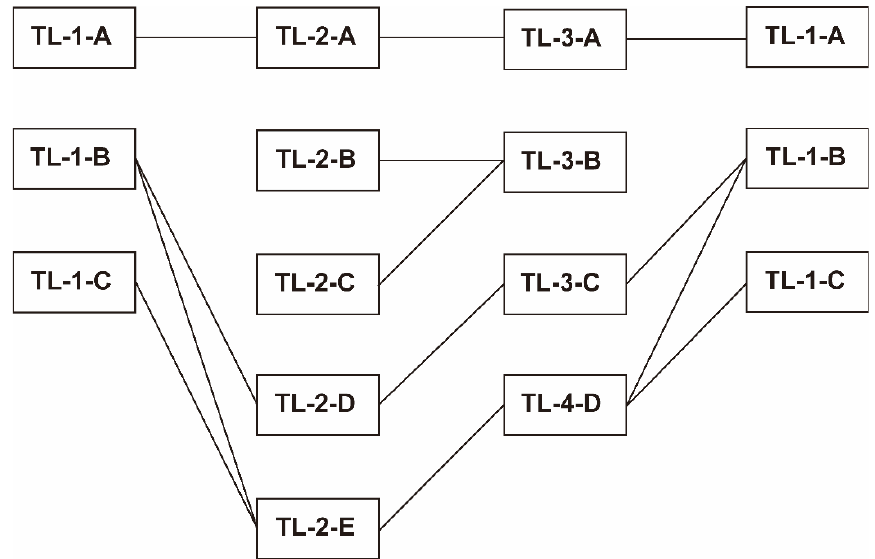
Figure 11. Statistical similarity between habitat groups along the three transect lines. Statistical similarity symbolized by the solid line: Mean − SD < Bray Curtis similarity < Mean + SD.